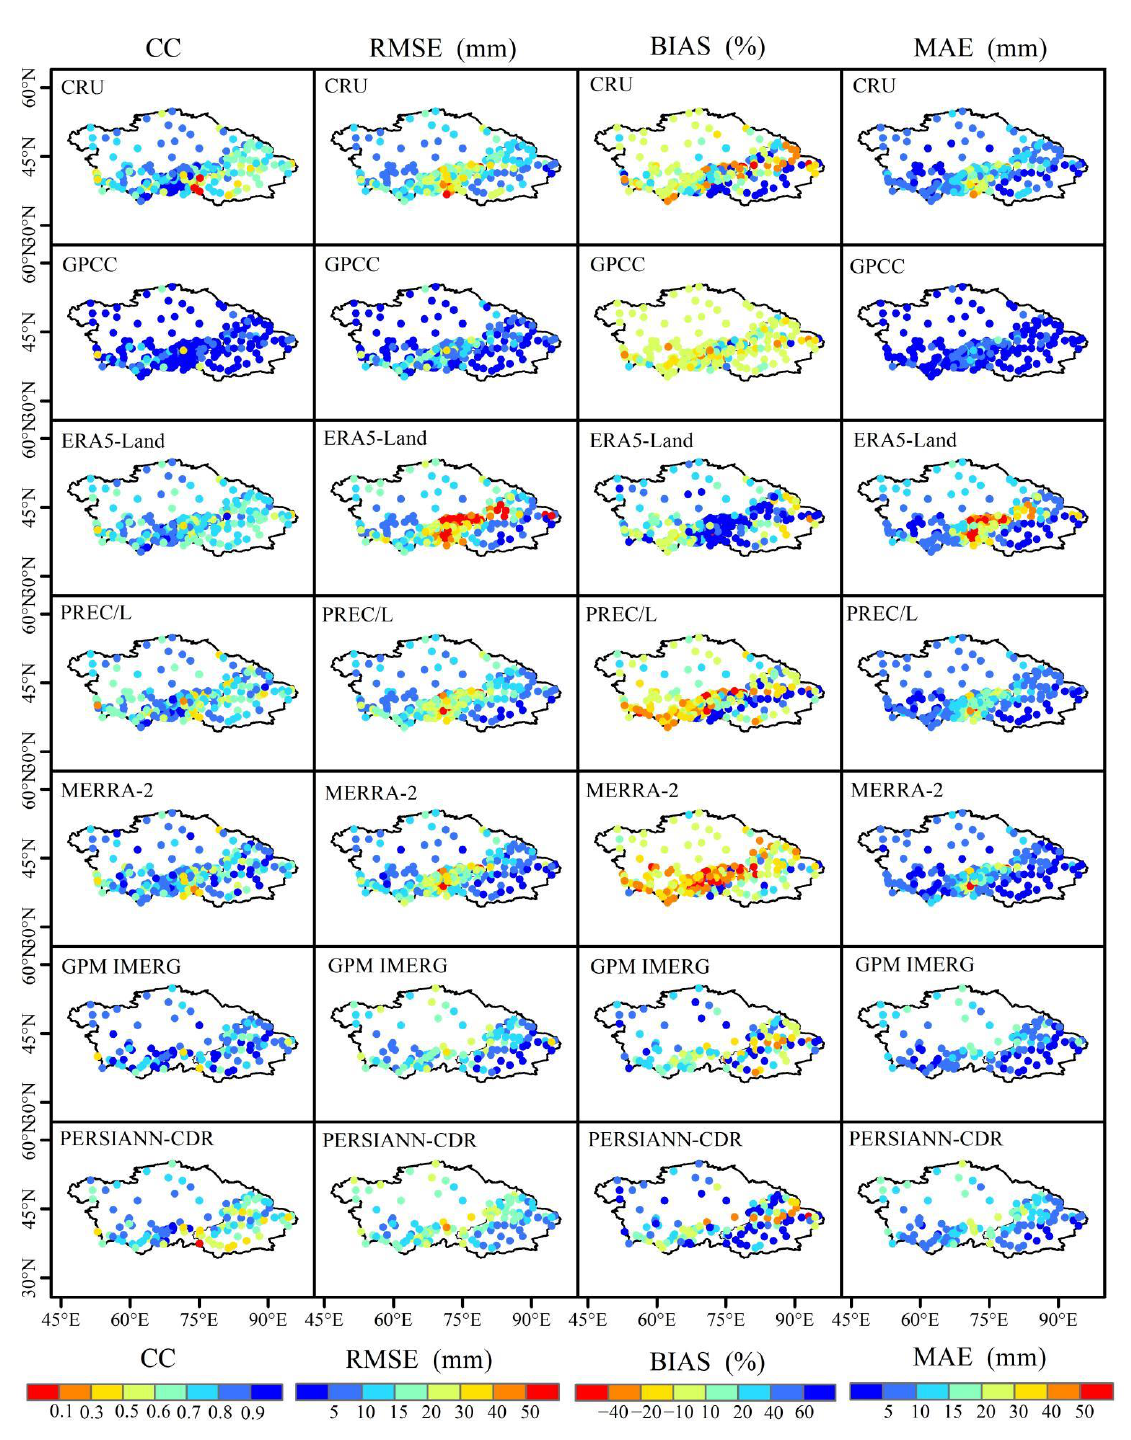
Figure 7. CC, RMSE, BIAS, and MAE between the seven monthly gridded precipitation products and OBS and OBS2 at stations in ACA during 1980 – 2019.